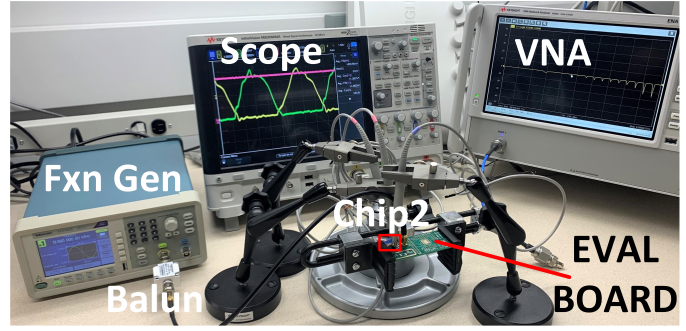
Figure 11. Testbench for measuring the active rectifier.